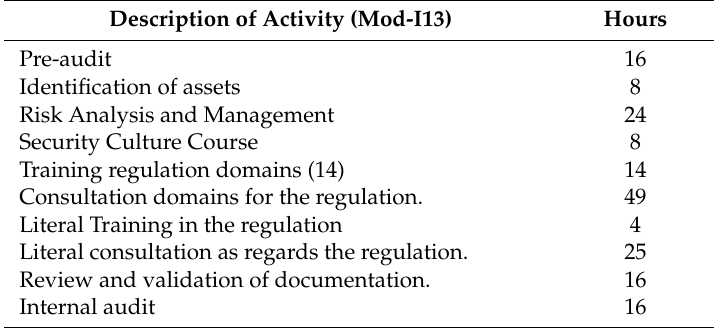
Table 2. Description of cost in consultation hours for the MARISMA installation model in interaction